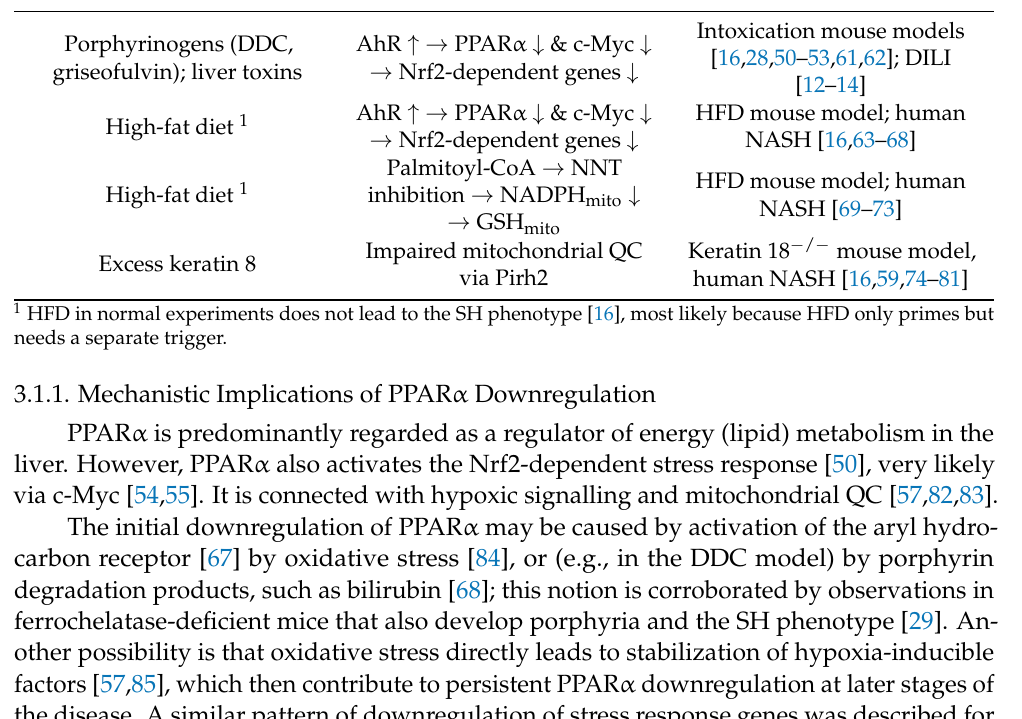
Table 1. Factors that prime the liver for extensive damage after triggering. Factor